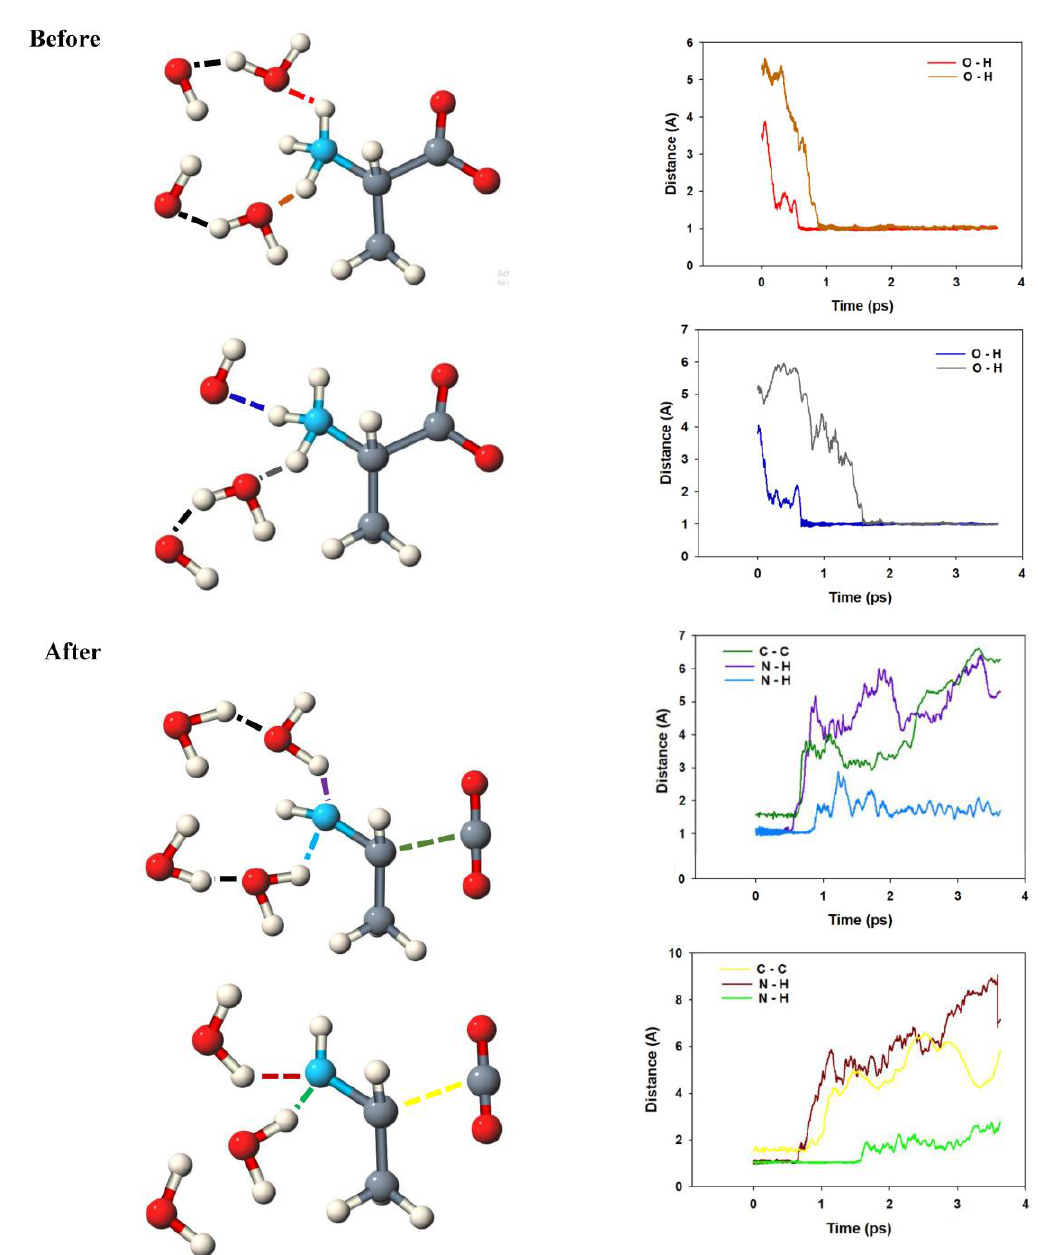
Figure 3. Sketch of the anodic reaction of two alanine zwitterions and behavior of the most relevant bonding interactions, deduced from the Car–Parrinello simulations.